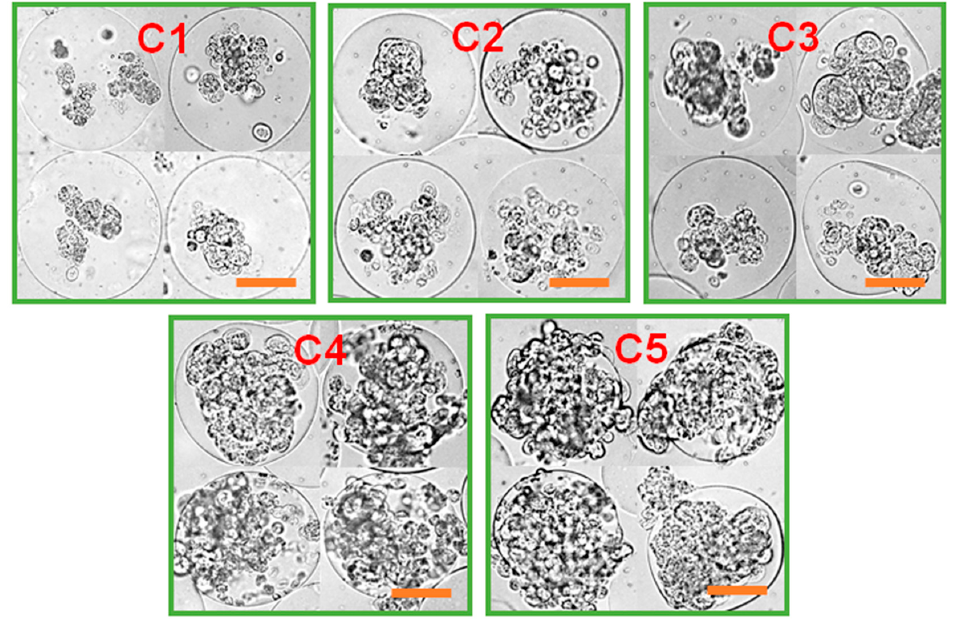
Figure 4. ( a ) The number of live MCF-7 cells at various times ( N t ) normalized with the initial number of live cells ( N 0 ) plotted over time; ( b ) The proliferation rate ( k ) obtained by fitting the plot in ( a ) with Equation (1). (* p < 0.05, n = 10). Equation (1). (* p < 0.05, n = 10).